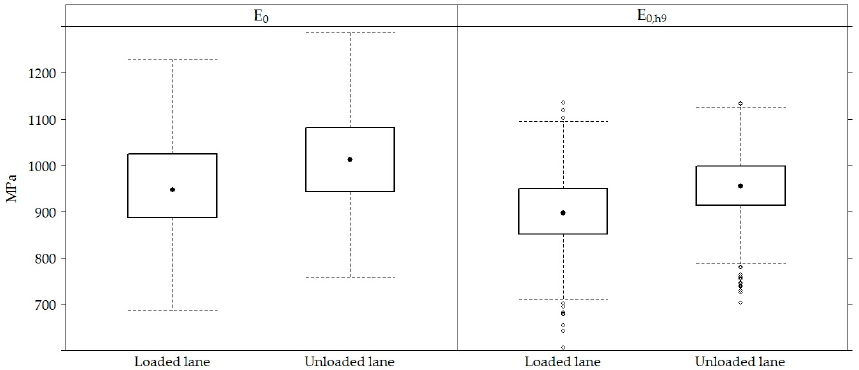
Figure 10. The box-plots of E 0 and E 0,h9 values in loaded and unloaded lanes.